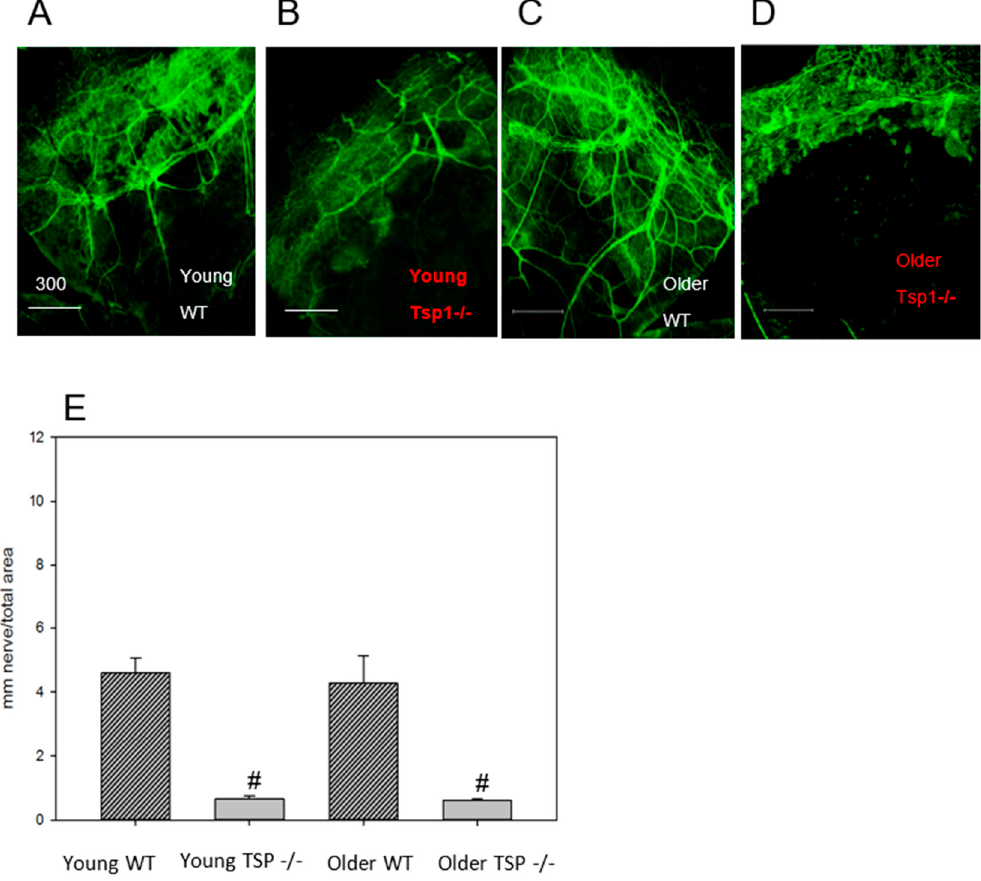
Figure 5. Whole corneas were fixed and stained with anti-Class III β -tubulin antibody. The number of nerves, number of nerve branches, and nerve density were measured and compared across groups. Both young (4-week-old) and older (12-week-old) WT mice displayed abundant nerve branches emerging from the nerve trunk near the limbus area ( A and C , respectively). The nerve density in corneas from TSP-1 − / − mice was significantly lower than that in age-matched WT counterparts ( B , D , and E ). n = 6 for all groups. Scale bars represent 300 μ m and # denotes significance from WT animals.